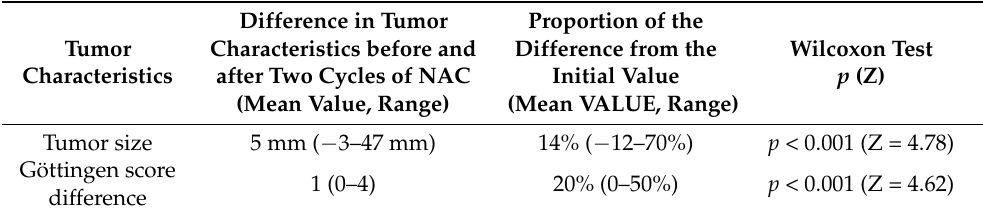
Table 4. Differences and percentages of differences in tumor characteristics before and after second cycle of